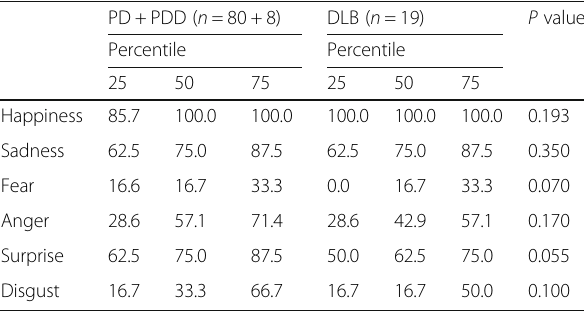
Table 1 Comparison of diagnosis breakdown and facial expression recognition test